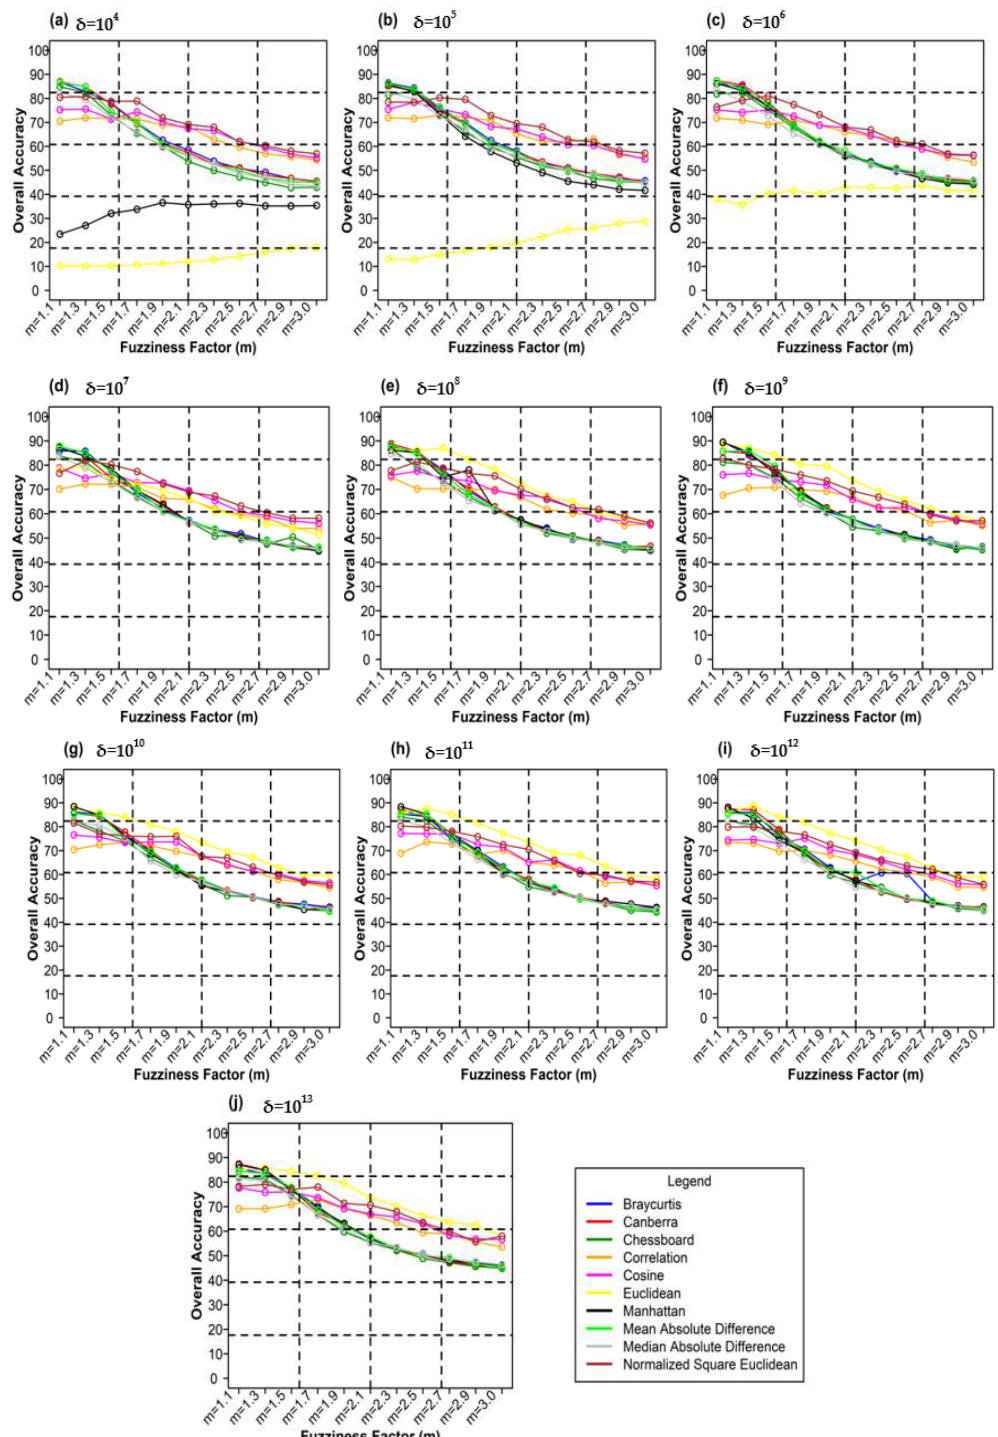
Figure 11. Comparison of overall accuracy in NLICM classifier for applying different distance measures, m (1.1 – 3.0), and ( a – j ) for site 1 (Haridwar).